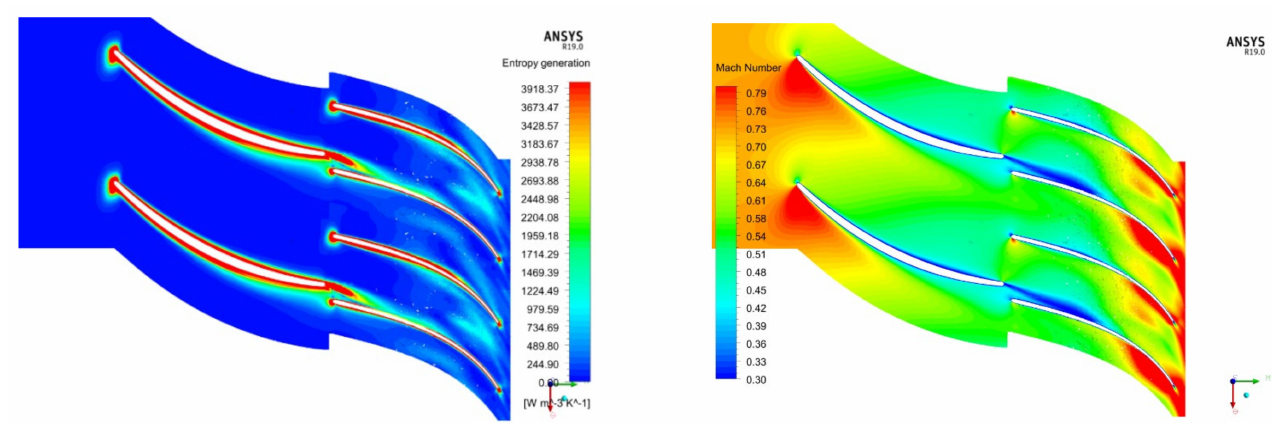
Figure 22. Entropy generation map ( left ) and Mach number ( right ) for 75% clock, 0.5 mm clearance. m r =